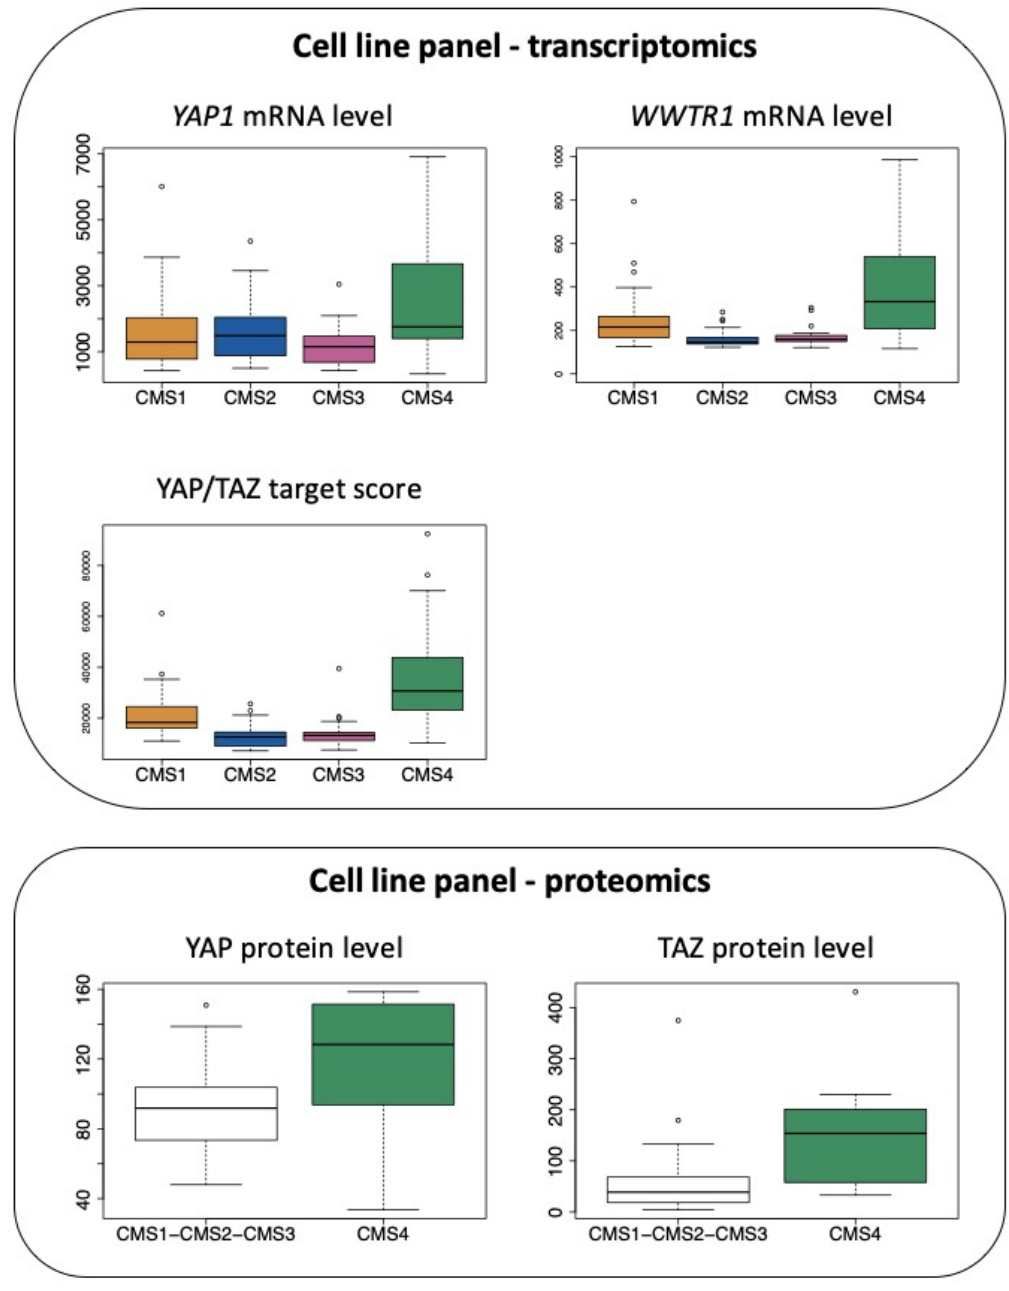
Figure 4. Expression of YAP and TAZ in CRC cell lines according to the CMS classification. Top panel: expression of YAP1 mRNA and WWTR1 mRNA as well as the determination of the YAP / TAZ target score as defined in [26] in the CRC cell line panel of the GSE59857 dataset [68] according to the CMS classification reported in [43]. p < 0.05 for CMS4 vs. CMS1 and p < 0.01 for CMS4 vs. CMS2 or vs. CMS3 for YAP1 . p < 0.001 and p < 0.005 for CMS4 vs. CMS2 or vs. CMS3, respectively, for WWTR1 . p < 0.0001 for CMS4 vs. other CMS for YAP / TAZ target score (Tukey post hoc test). Bottom panel: protein levels of YAP and TAZ determined in the CRC cell line panel proteomic study [69], in CMS4 cell lines vs. other cell lines. p < 0.05 for CMS4 vs. other CMS for YAP and TAZ (Kruskal–Wallis chi-squared test).